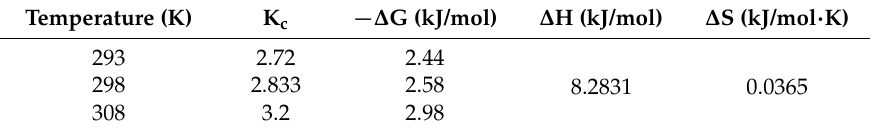
Table 4. Equilibrium constant and thermodynamic parameters at different temperatures.